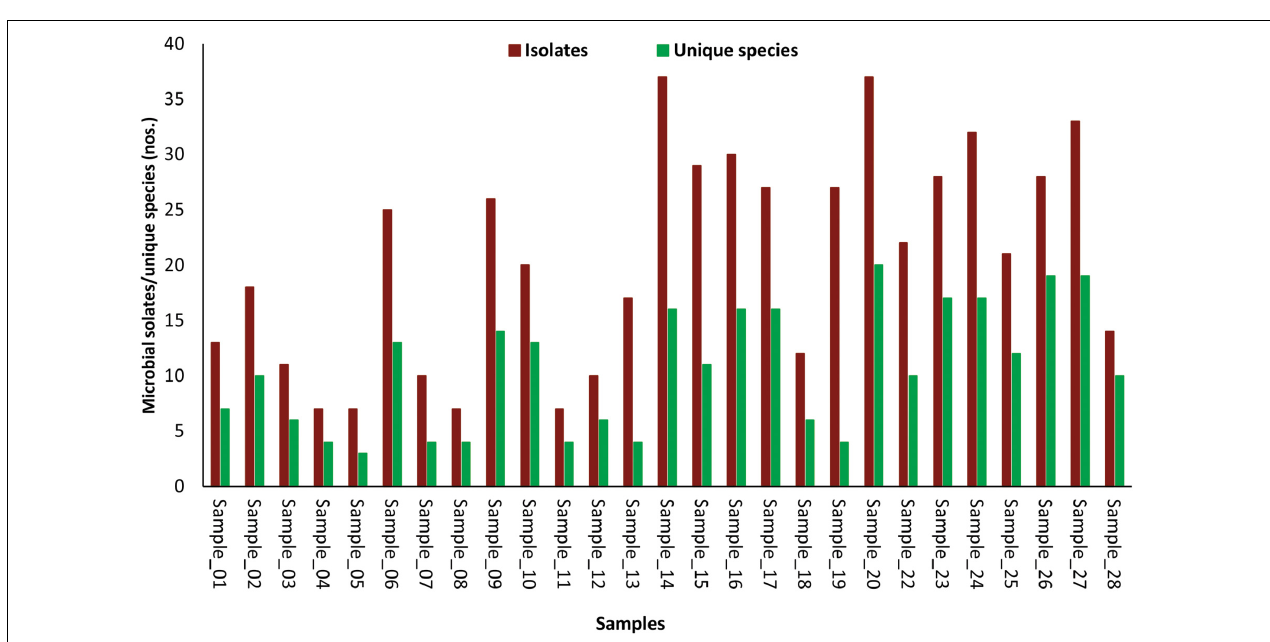
FIGURE 2 | Bar-diagram depicting the number of morphotypes isolated and number of microbial species identified from individual samples of cellular phones.